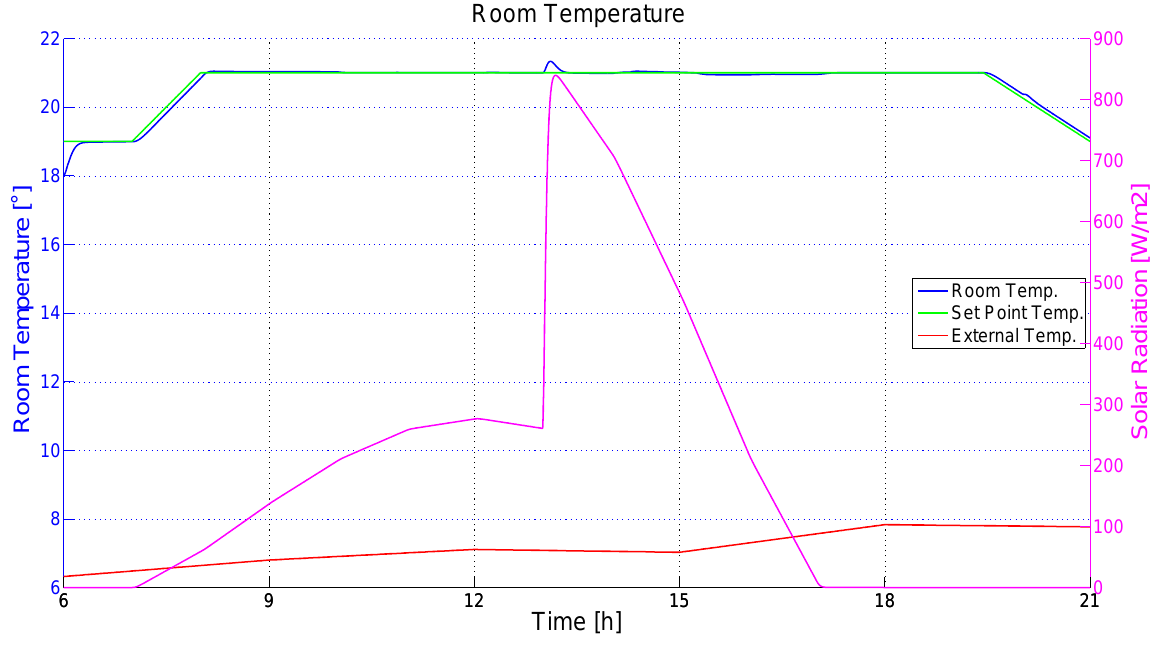
Figure 30. Control results (second scenario, modified control system, Comfort policy): room temper- ature (CV), outside temperature, and solar radiation (DVs).